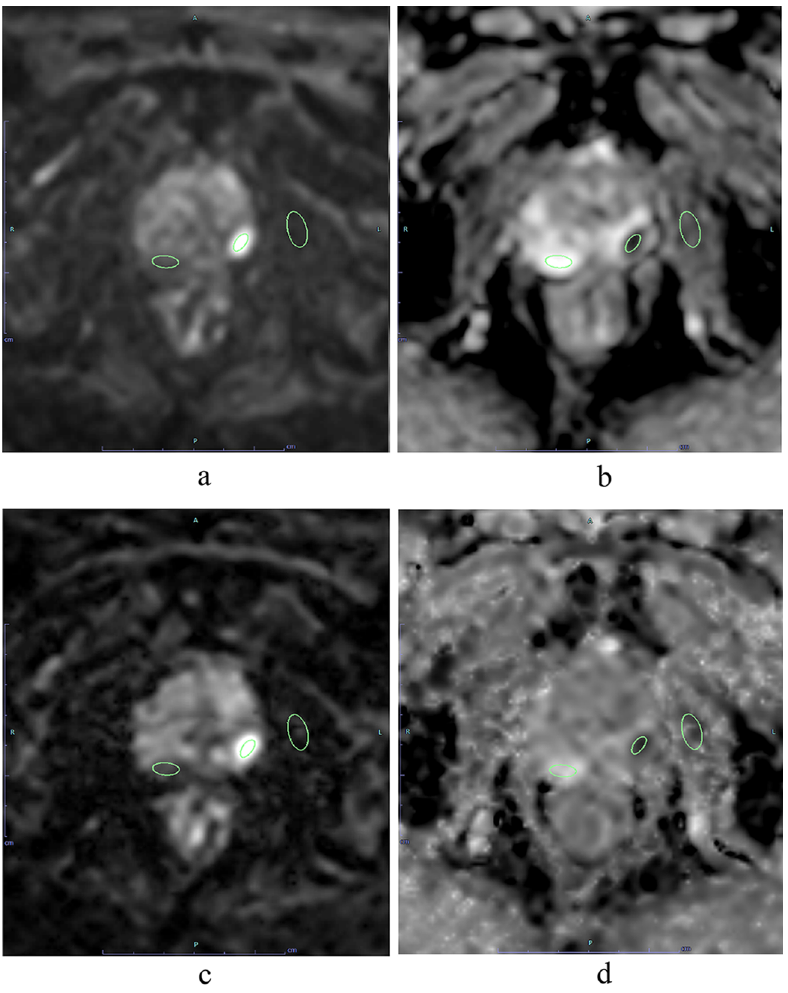
Figure 1. Region of interest (ROI) placement for signal intensity and ADC measurements of prostate cancer region in left peripheral zone and benign prostatic region in right peripheral zone and for signal intensity measurement of left internal obturator muscle region. The ROIs for PC region, benign prostatic region, and internal obturator muscle region in one of these four MR images was copy-and-pasted into the other three MR images [ssEPI DWI ( a ), ssEPI DWI ADC map ( b ), msEPI DWI ( c ), and msEPI DWI ADC map ( d )].